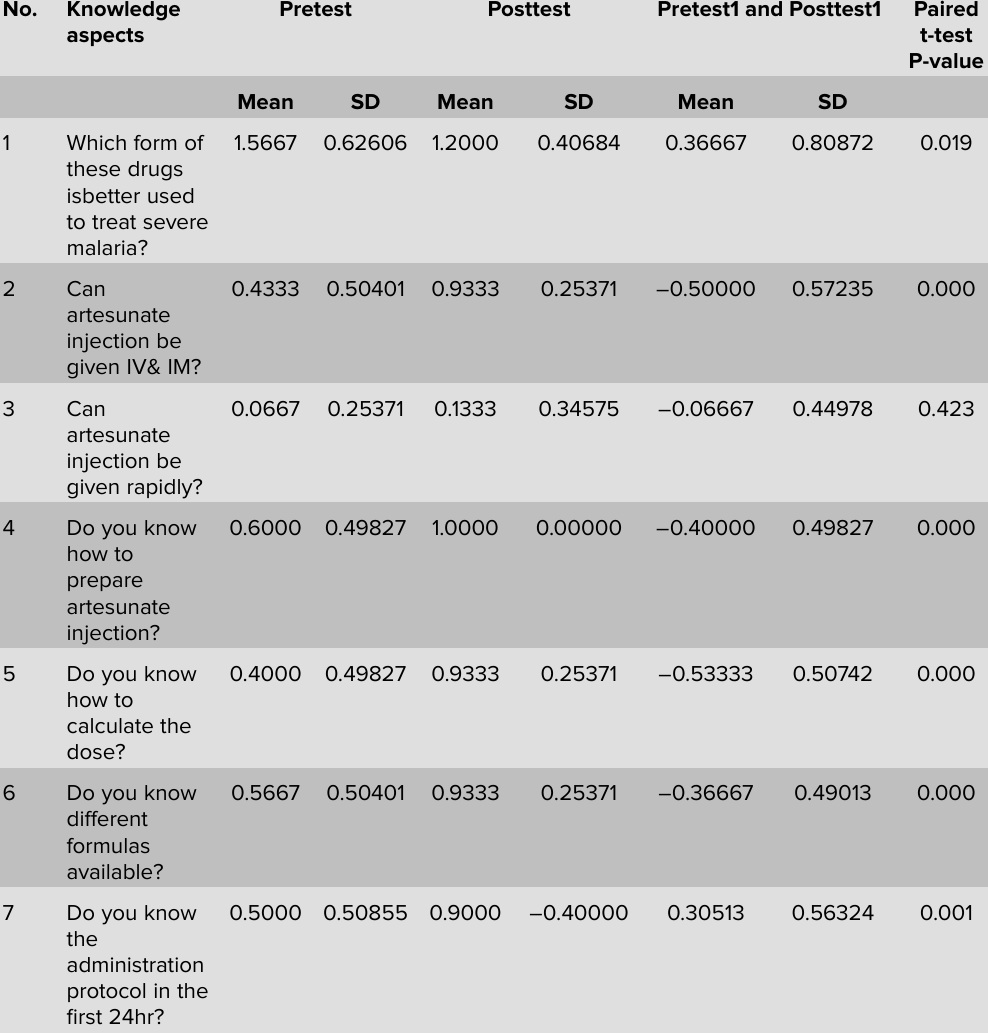
TABLE 2: Students’ knowledge about injectable artesunate (injAS) ( n